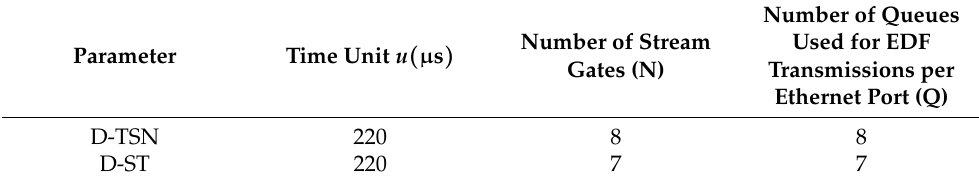
Table 4. Network configuration parameters for D-TSN and D-ST.